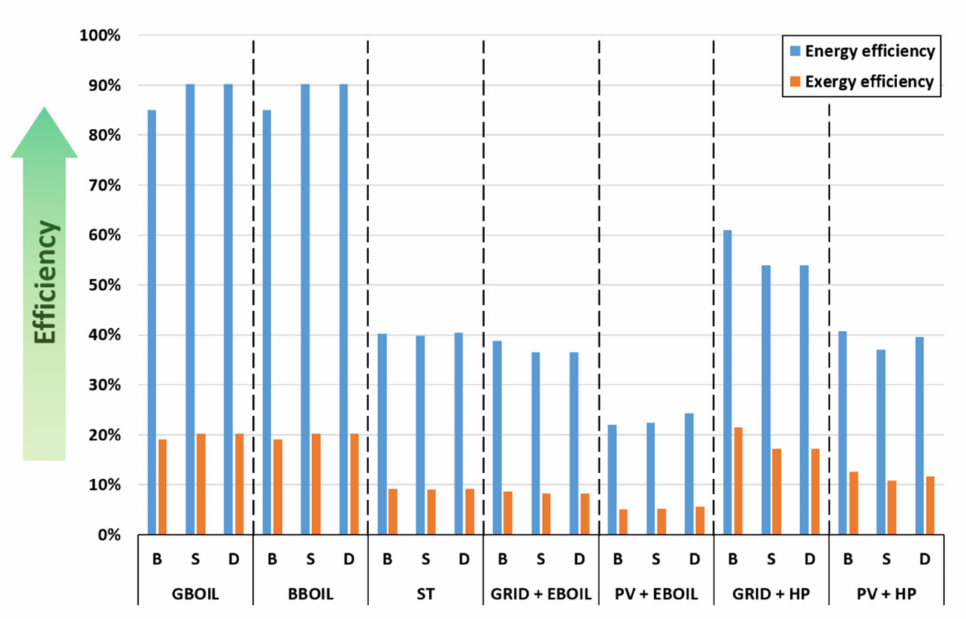
Figure 3. Overall energy and exergy efficiencies for each solution, at each scale size. D = District-scale sizing; S = Sector-scale sizing; B = Building-scale